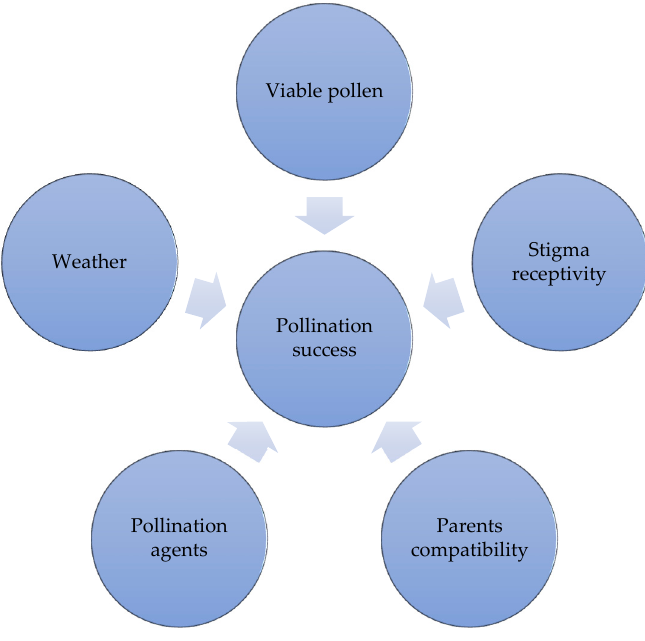
Figure 1. Factors linked to plant pollination.